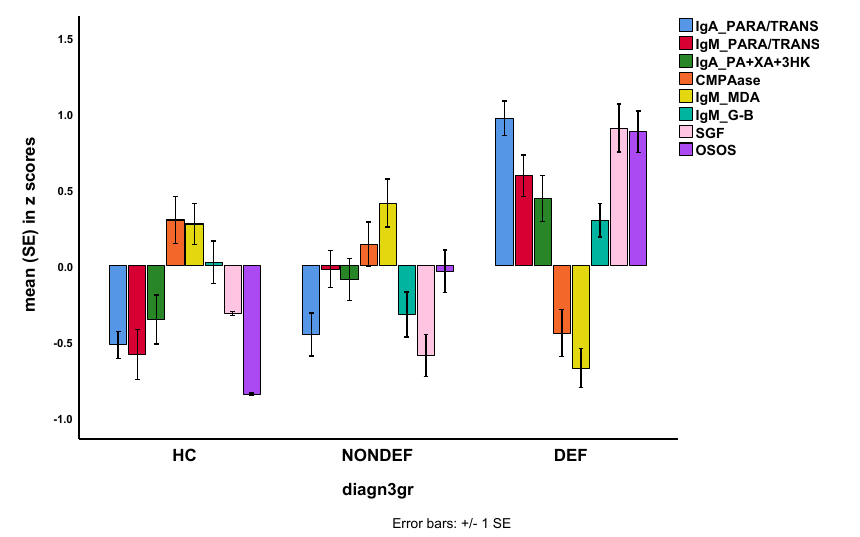
Figure 2. Mean (SE) values of all biomarkers, the OSOS (overall severity of schizophrenia) general factor (GF) score, and the single-group factor score. IgA/IgM PARA/TRANS: IgA/IgM directed to paracellular / transcellular proteins; IgA PA+XA+3HK: IgA directed to the sum of three neurotoxic tryptophan catabolites, namely picolinic acid, xanthurenic acid, and 3-OH-kynurenine; CMPAase: paraoxonase (PON)1 (CMPAase) activity; IgM MDA: IgM directed to malondialdehyde; IgM G-B: IgM directed to Gram-negative bacteria; HC: healthy controls;